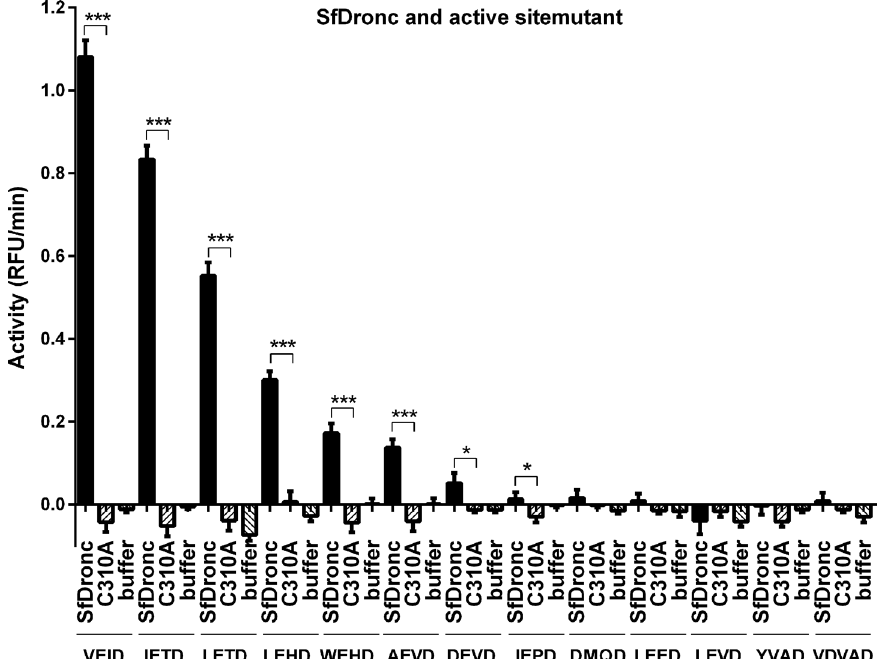
Fig 5. Recombinant SfDronc possessed strongest activity on initiator caspase substrates. Wild type SfDronc and active site mutant SfDronc-C310A with C-terminal His-tag were incubated, respectively with 13 types of synthetic caspase substrates (20 μ mol/L) and subjected to caspase activity assay. Caspase activity was indicated as the changes in relative fluorescence units (RFU) per minute. The data were presented with the SD from three independent experiments, and statistical significance was calculated by t test, *** P < 0.001, * P <